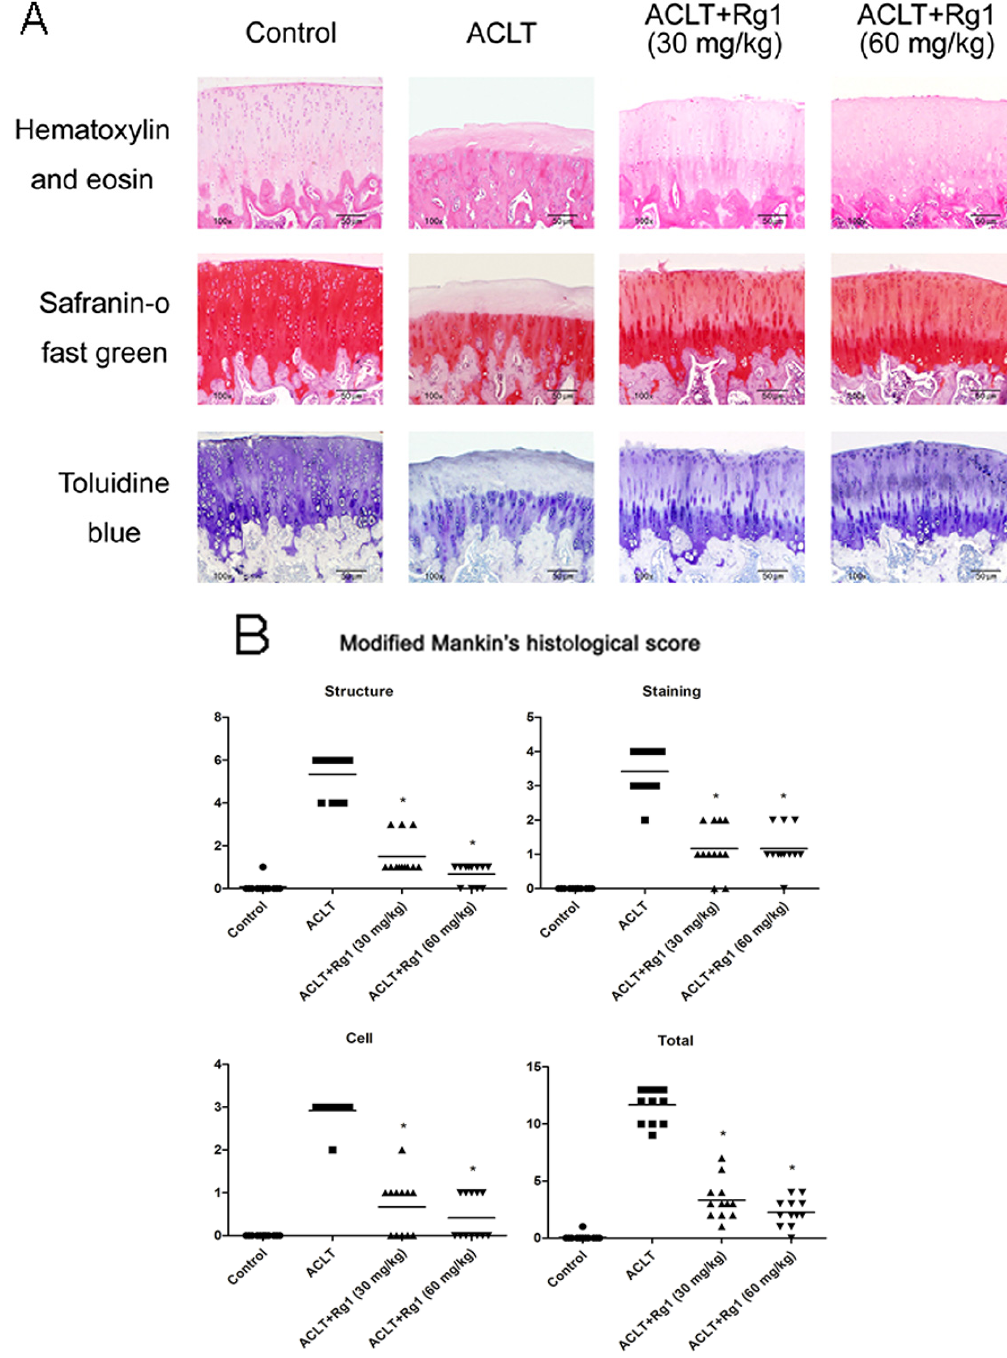
with the control values, and lower in the R1 and R2 groups than the ACLT group. Percentages